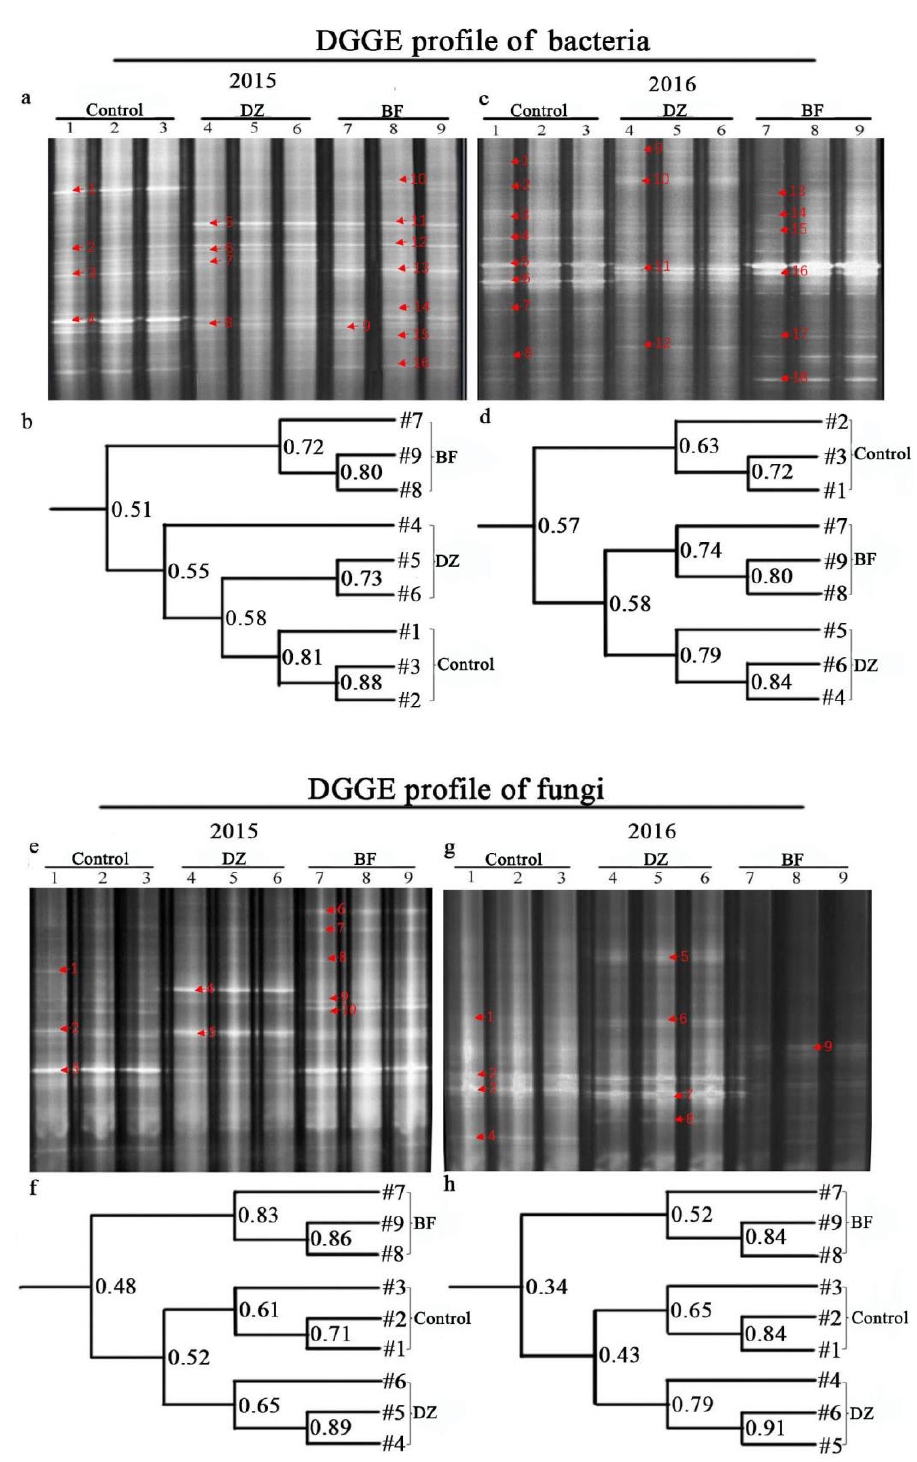
Figure 4. Denaturing gradient gel electrophoresis (DGGE) profiling of the soil microbiota: ( a ) and ( c ) bacterial community in 2015 and 2016, ( b ) and ( d ) UPGMA cladograms based on the Dice similarity of the composition of bacterial communities in chrysanthemum rhizosphere soil in 2015 and 2016. ( e ) and ( g ) fungal community in 2015 and 2016; ( f ) and ( h ) UPGMA cladograms based on the Dice similarity of the composition of fungal communities in chrysanthemum rhizosphere soil in 2015 and 2016, “#” indicated the number of lanes in the DGGE profile. Note: numbered fragments were excised, reamplified, and sequenced.